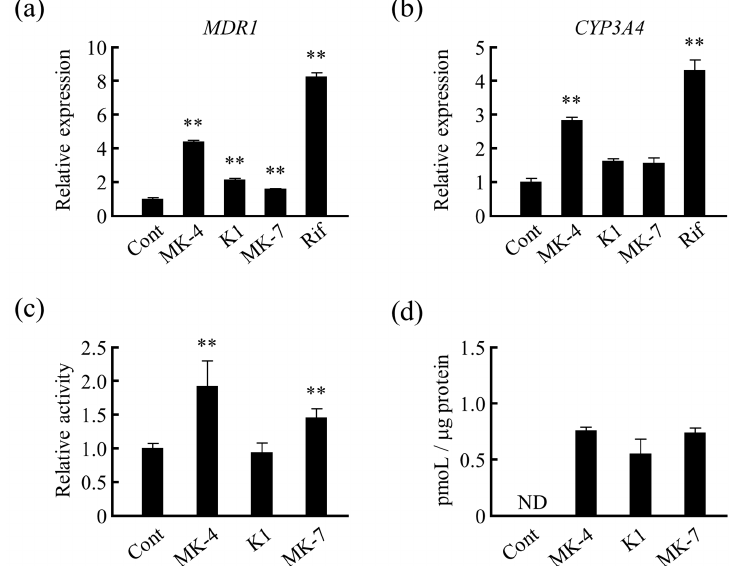
Figure 4. Effects of different forms of vitamin K (VK) on drug metabolism-related gene expression. Effects of treatment with different forms of VK for 24 h on ( a ) CYP3A4 and ( b ) MDR1 mRNA levels in LS180 cells were analyzed. Relative mRNA levels were normalized to that of eukaryotic translation elongation factor 1 α 1 mRNA. ( c ) Effect of different forms of VK on MDR1/pGL4-TK reporter gene activity was analyzed. ( d ) Uptake of VK content by LS180 cells after 24 h treatment with different forms of VK was measured using HPLC. Data are expressed as the mean ± standard error of the mean, n = 3, ** p < 0.01 vs control (Cont). MK-4, menaquinone-4; K1, vitamin K 1 ; MK-7, menaquinone-7; Rif, rifampicin; HPLC; high-performance liquid chromatography. MDR1 , multi- drug resistance; CYP3A4 , cytochrome P450 3A subfamily 4.